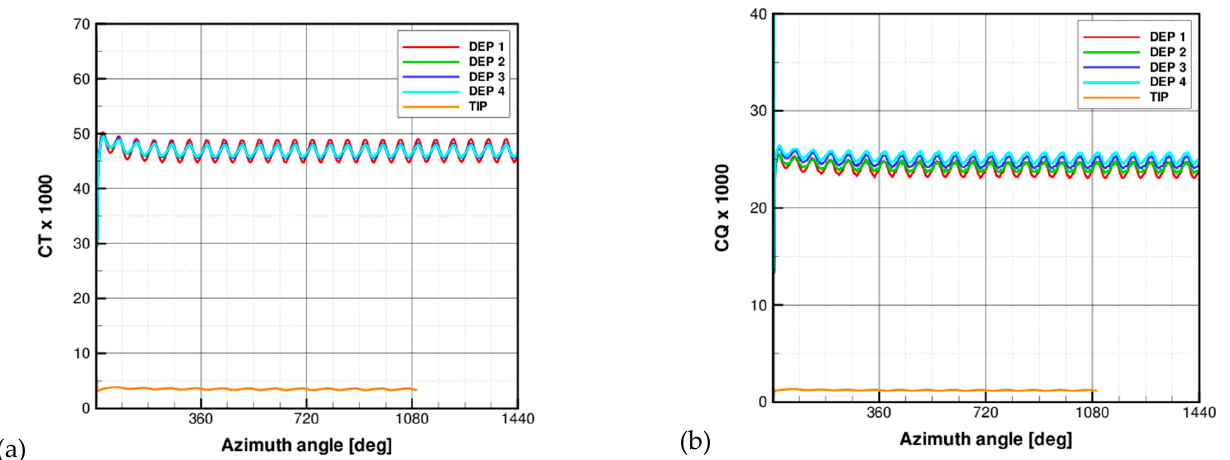
Figure 16. Motorization 2—thrust ( a ) and induced-torque ( b ) time histories in a 100%-ETR climb.